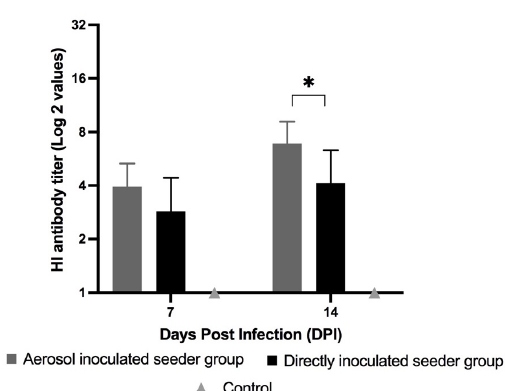
Figure 3. Average serum HI antibody titers against H9N2 AIV in the inoculated seeder chickens. On day fourteen of age, the chickens were inoculated either via aerosol or direct inoculation or via